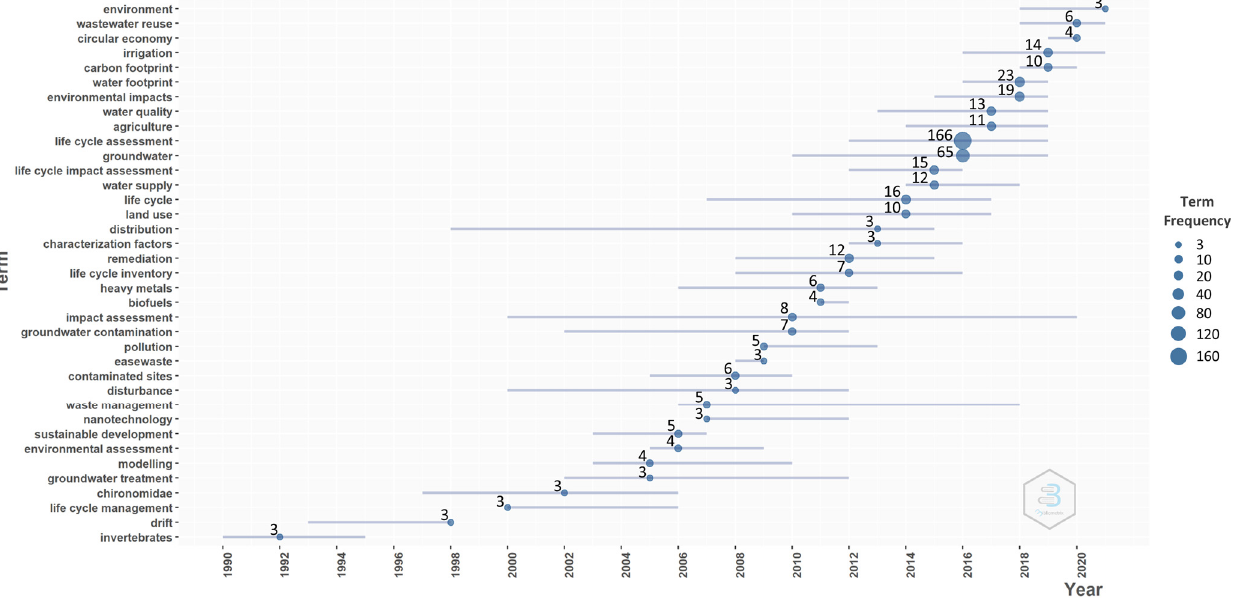
Figure 9. The trend of Keywords by year of the scientific field. Documents: 306 documents only from Scopus and 158 from WoS and 316 from both databases.